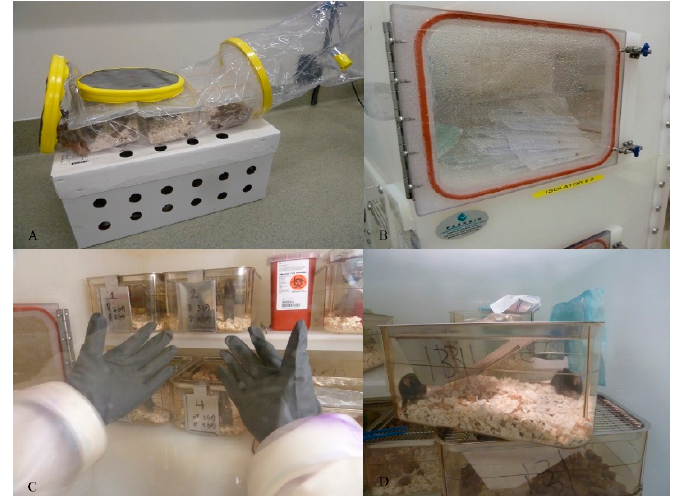
Figure 2. Sterility flow. ( a ) Shipment box used to deliver mice in a sterile environment. Flexible boxes are sealed with layers of tape and contain up to three cages. ( b ) Sterile port, with a hermetic door. Specific protocols outline procedures for introduction of supplies. ( c ) Interior gloves worn on top of sterile latex gloves to manipulate mice. ( d ) A cage with germ-free C57 BL/6 mice, containing specific autoclaved bedding, paper, food, and water.